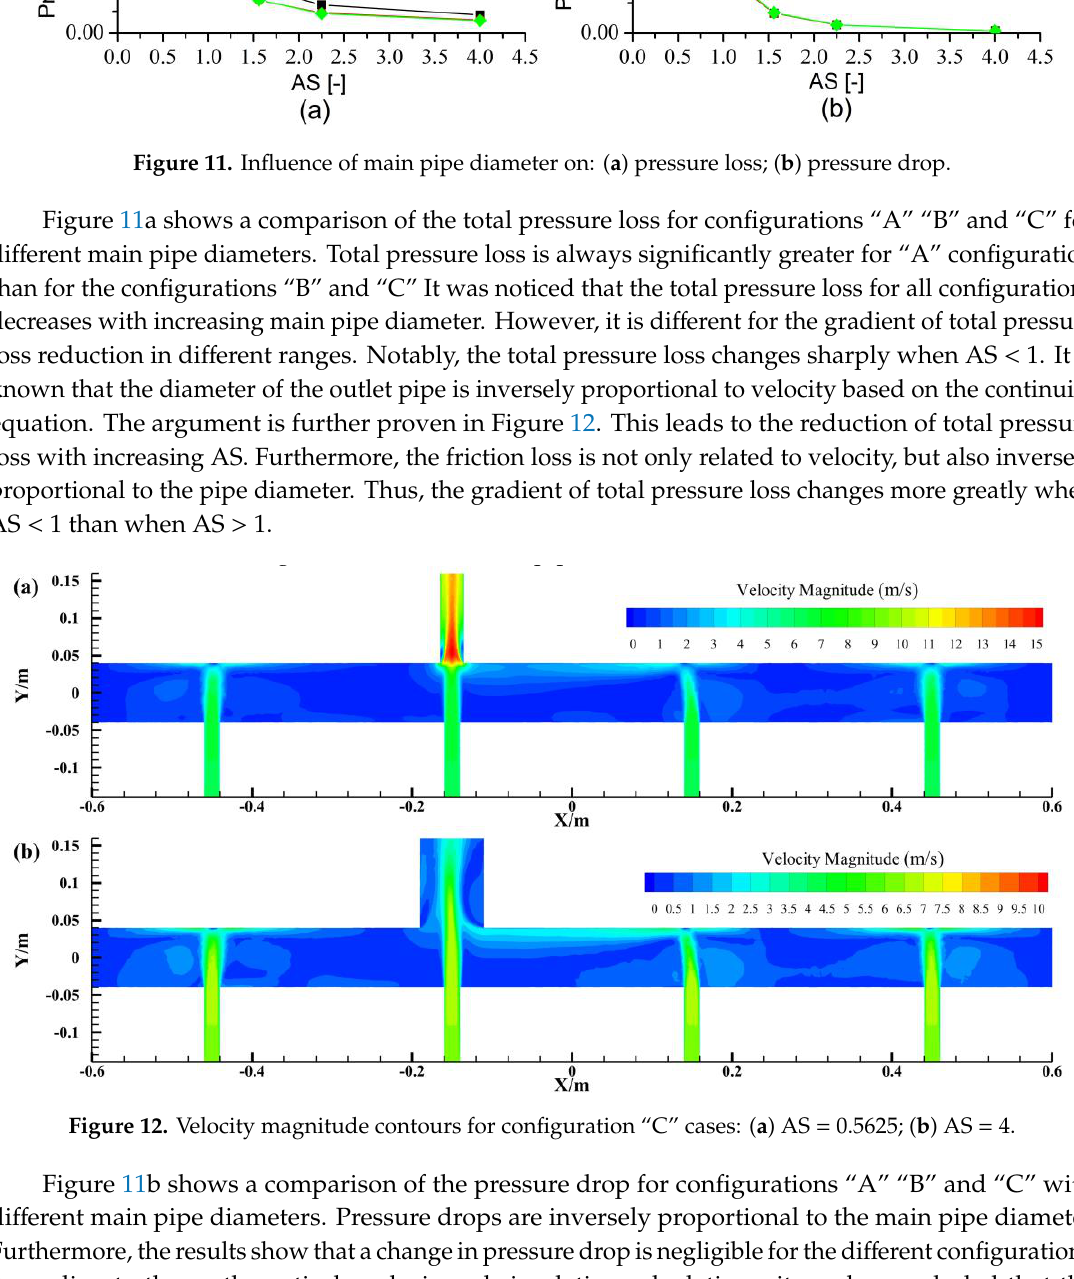
Figure 11. Influence of main pipe diameter on: ( a ) pressure loss; ( b ) pressure drop.